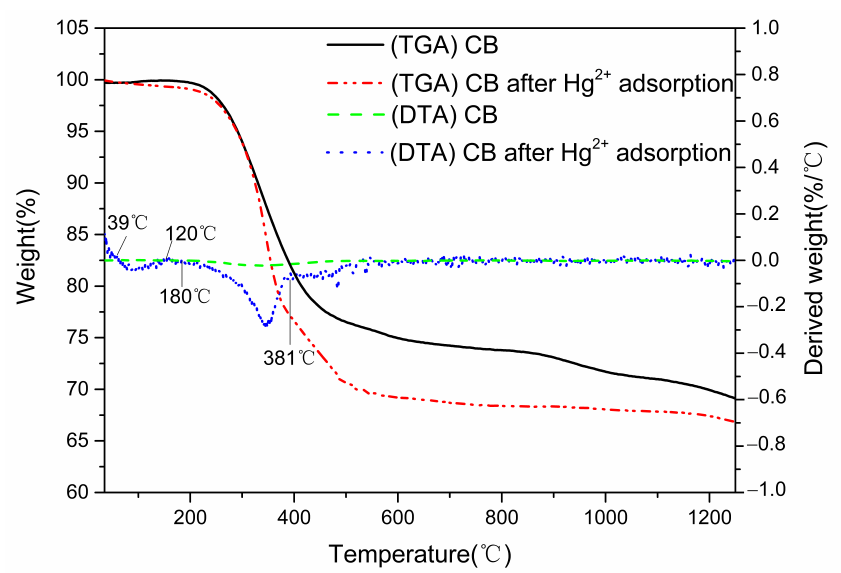
Figure 5. The TGA and DTG curves of the CB before and after Hg 2+